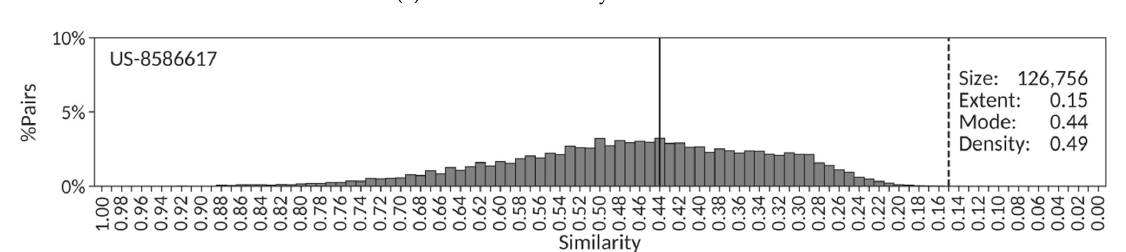
Figure 2. Centroid ( a ) and all pairwise ( b ) similarity distributions for the set of molecules exemplified in SureChEMBLccs patent US-8586617. Additionally, included ( a ) is a sample of chemical structures with their SCHEMBL identifiers and similarity values (in parenthesis). The extent and mode are indicated, respectively, by vertically dashed and solid lines.